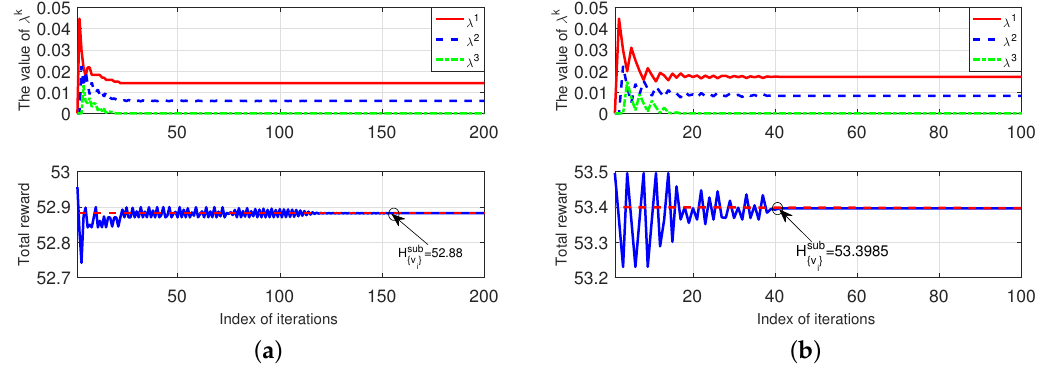
Figure 4. Convergence of our proposed Algorithm 5. ( a ): { ν i } = { 1,2,3,4,5 } . ( b ): { ν i } = { 3,3,3,3,3 } .